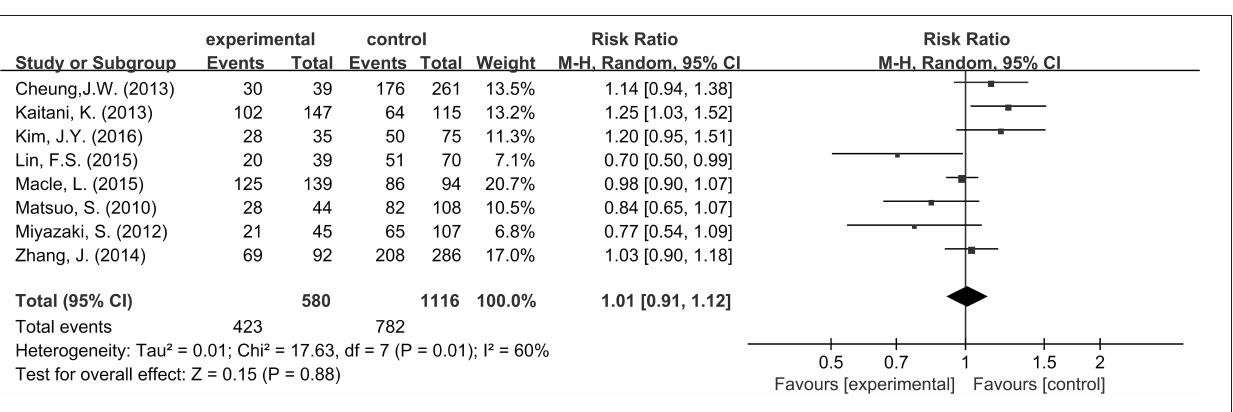
Frontiers in Physiology |